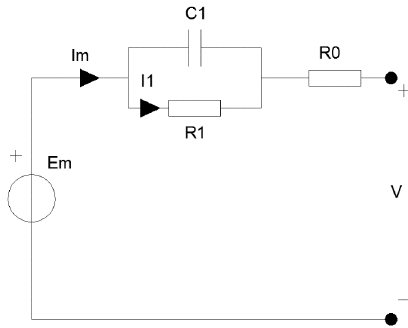
Figure 5. Equivalent circuit model with one RC